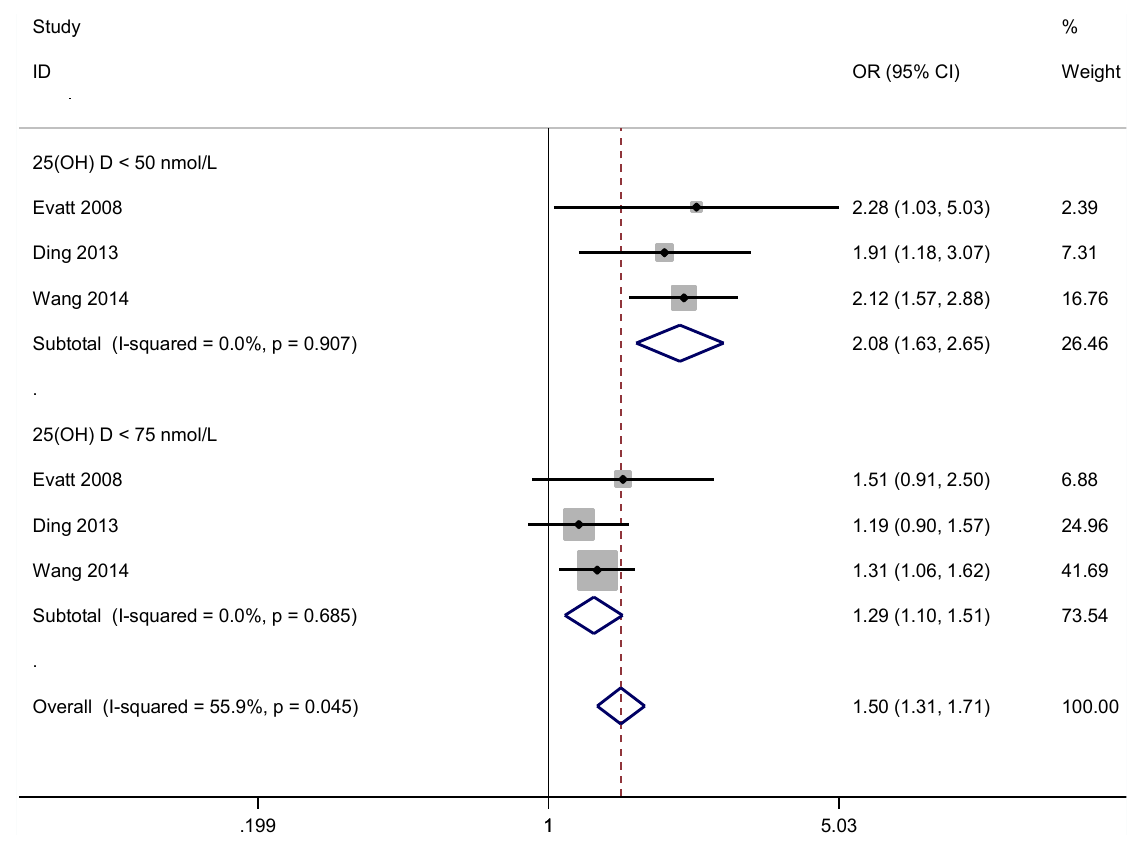
Figure 2. Forest plots of deficient and insufficient vitamin D levels and risk of Parkinson’s Disease